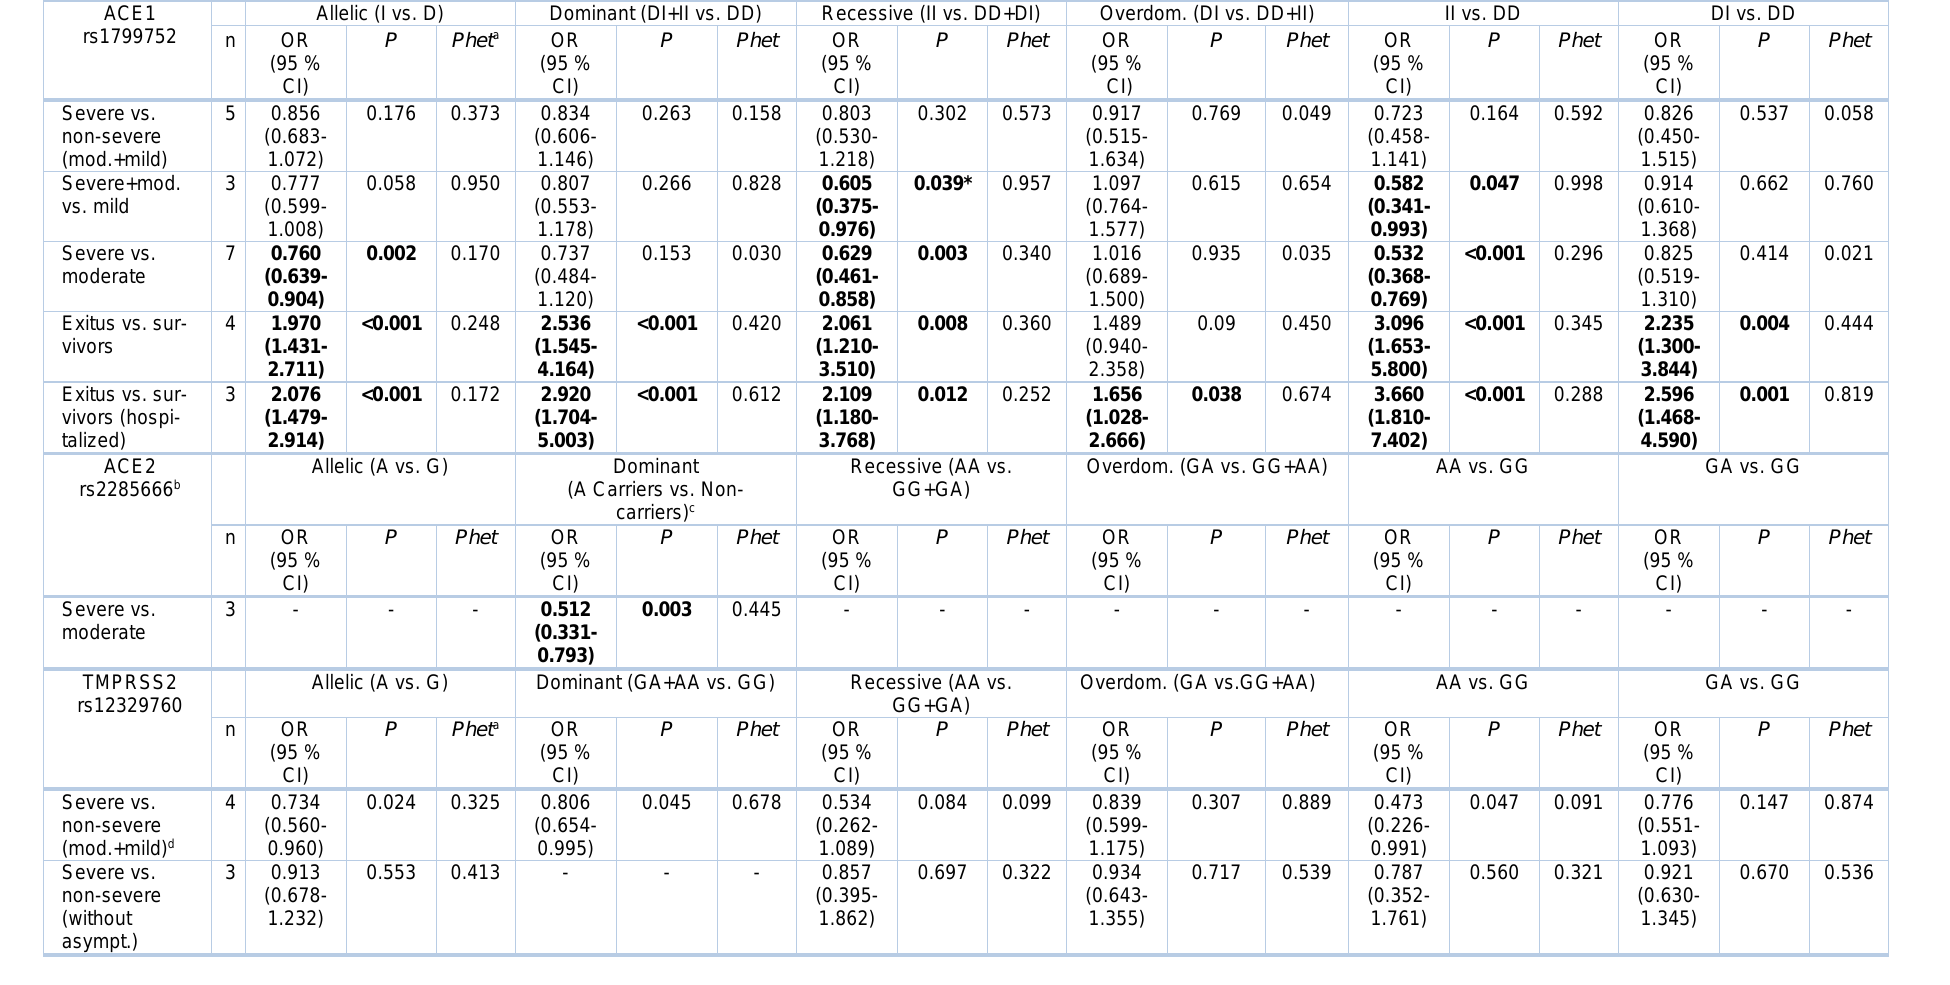
Table 2: Meta-analysis of association between genetic variants in ACE1 , ACE2 , TMPRSS2 , IFITM3 and VDR and COVID-19 severity ACE1